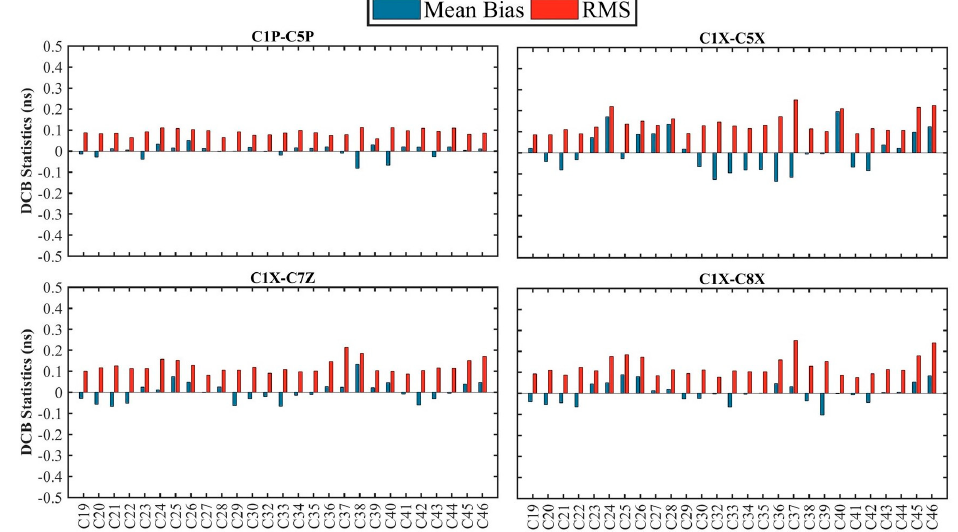
Figure 3. The mean bias and RMS of our estimated C1P-C5P, C1X-C5X, C1X-C7Z, and C1X-C8X, of BDS-3 satellite DCBs, with respect to the direct values provided by CAS products.